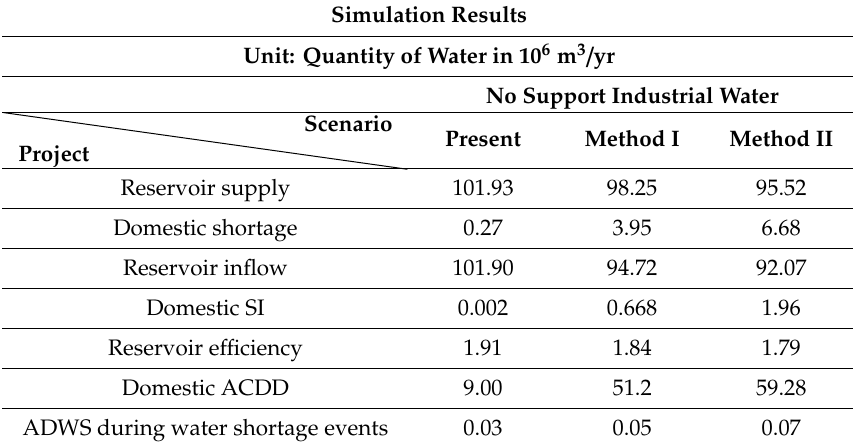
Table 7. Comparison of historical and synthesis flow data. SI, Shortage